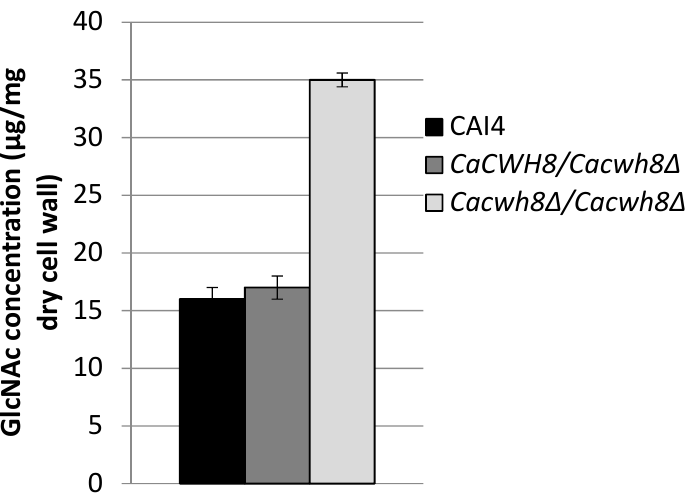
Figure 11. Cell wall chitin content in the control C. albicans strain CAI4 and the CaCWH8 mutants. Chitin was determined as free GlcNAc after hydrolysis of the cell wall with 6% KOH and enzymatic digestion with chitinase.